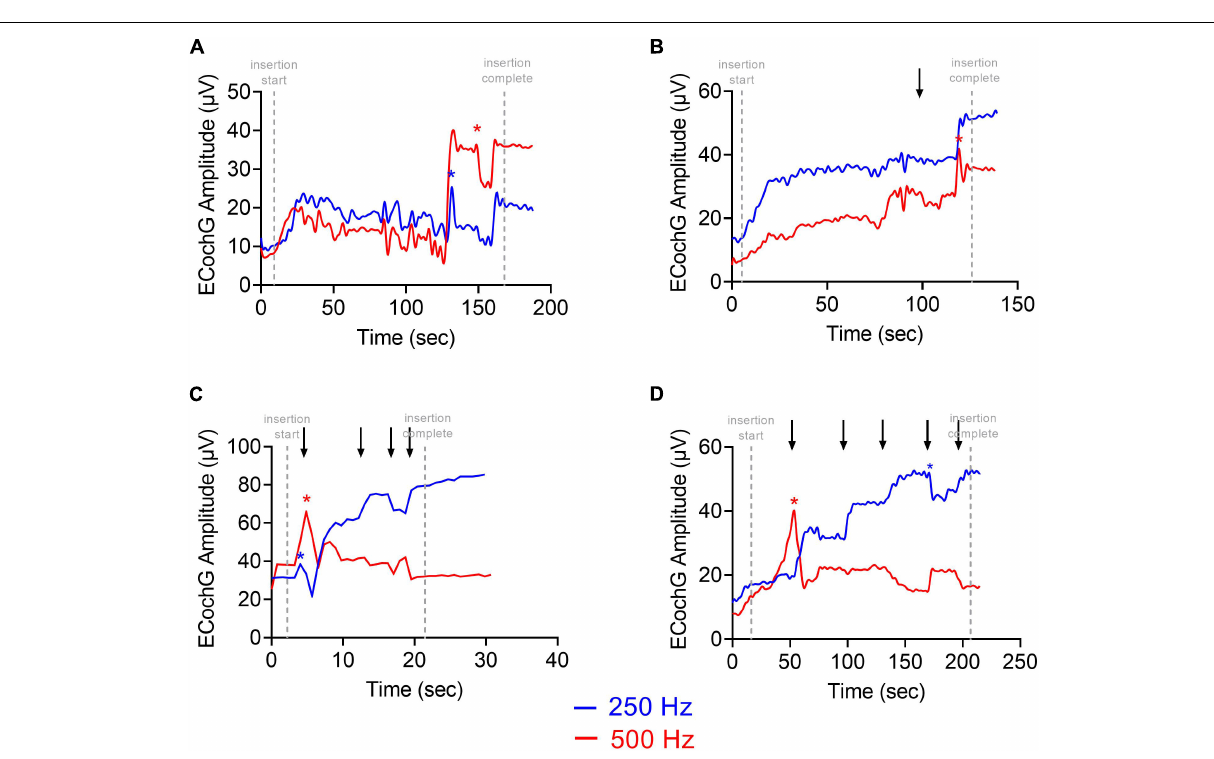
FIGURE 3 | Patient examples of ECochG response to multifrequency ECochG using 250- and 500-Hz tone burst. (A–D) Show four different insertion tracks. (A) No asynchrony between 250- and 500-Hz response. (B) Overall rise in response with one dyssynchronous point (marked with black arrow) where there is stability in 250-Hz response and drop in 500-Hz response. (C,D) Multiple dyssynchronous points (black arrows) noted between 250- and 500-Hz response with overall rise in 250-Hz response and drop in 500-Hz response. CM Drops > 30% are shown as